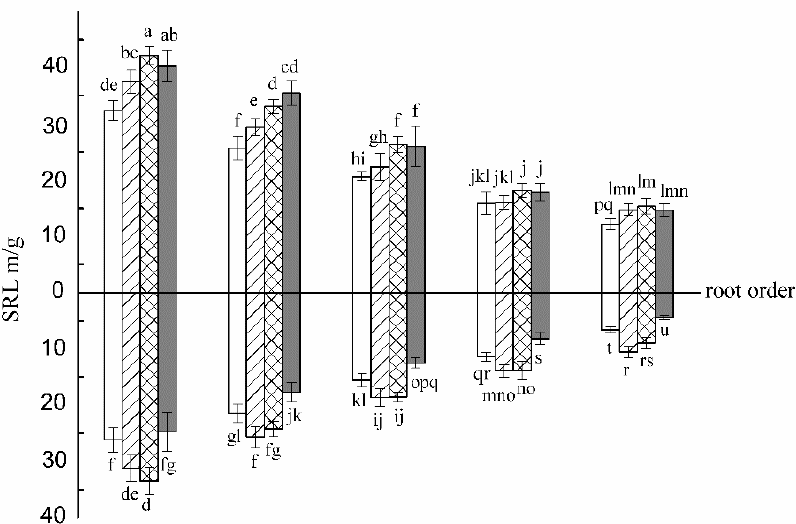
Figure 3. The effect of crop tree management on the SRL at different distances from the target Pinus massoniana . The X axis is the first to the fifth root order. The bars above the X axis represent the crop trees, and the bars below the X axis represent the noncrop trees. I, II, III, and IV represent the distance of fine roots to the target tree at 0–0.5, 0.5–1, 1–1.5, and 1.5–2 m. Each bar represents the mean ± SD with three replicates. Different letters above or below each bar indicate significant differences among groups compared by Fisher’s LSD test at p < 0.05.